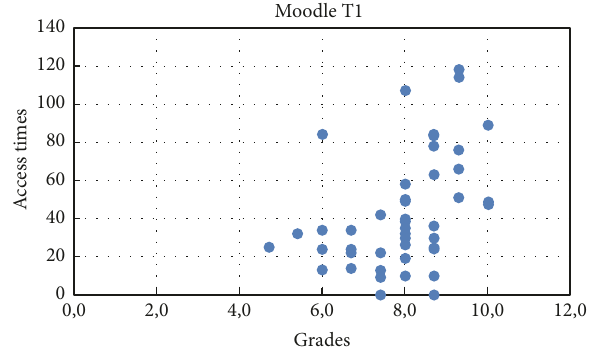
Figure 2: Scatter plot showing the amount of hits in relation to the marks obtained in the second test. It can be observed that students who access less a digital teaching platform had a direct influence on their